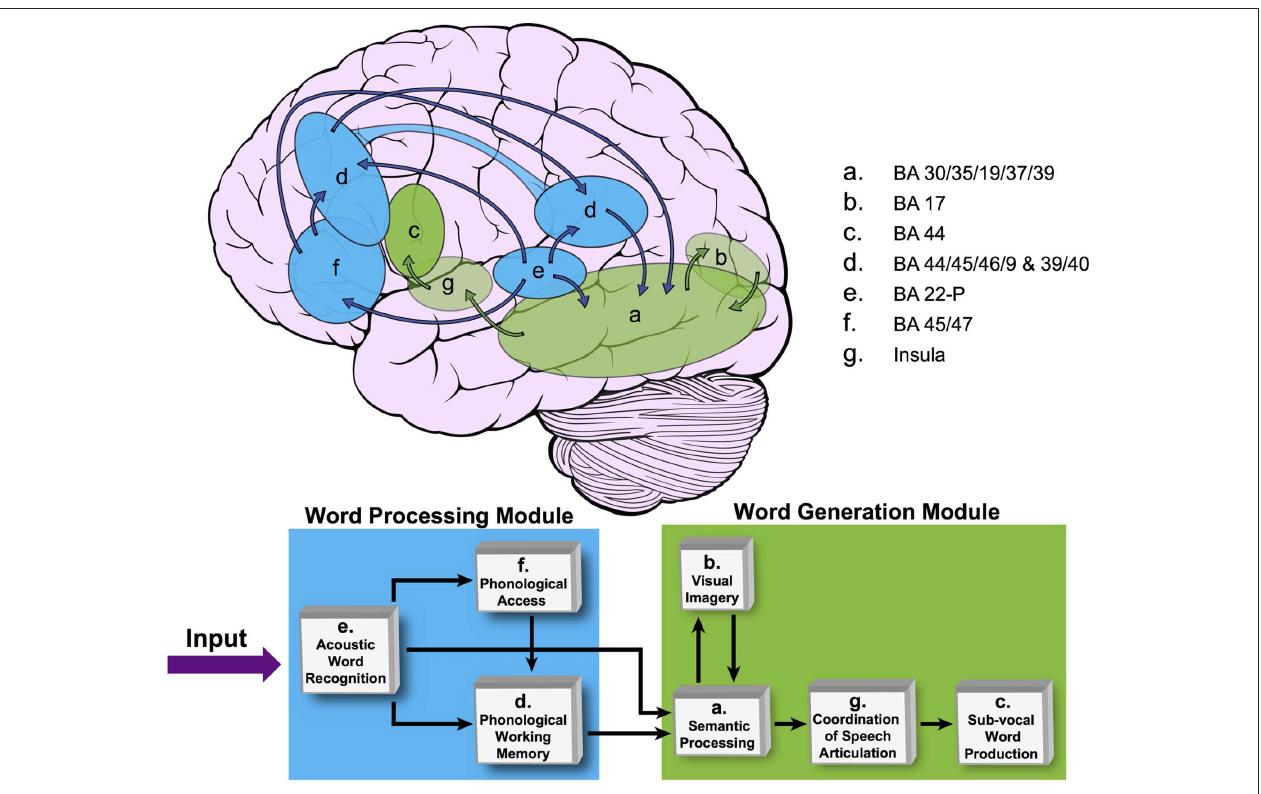
of the brain. IC d is represented in both frontal and temporal–parietal regions as reflected in the distributed nature of this left-lateralized network. The network is divided into word processing (shown in blue) and word generation modules (shown in green). The SEM block diagram at bottom shows how these brain networks are